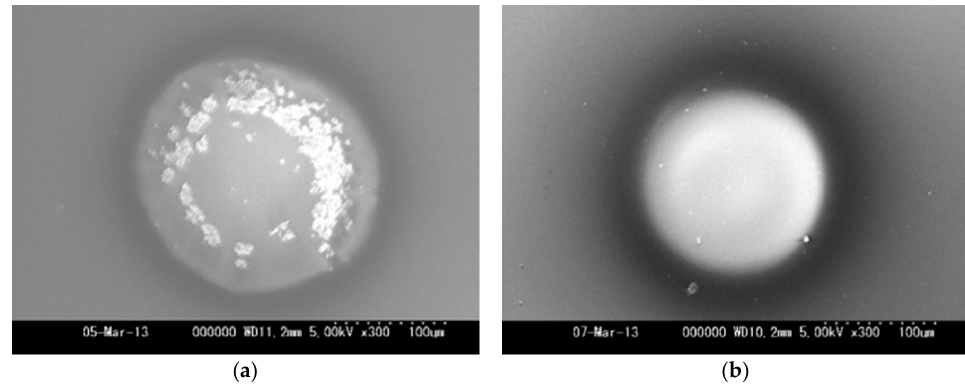
Figure 7. SEM images of cathode (Si) surfaces after 5 s operation at 1000 V source voltage, 6.6 sccm C 2 H 2 flow rate, 80 kPa inlet pressure, and the electrode gap distance of ( a ) 100 and ( b ) 200 μ m. Figure 8a,b show SEM images of a deposited film on Si wafer from top view and side view, respectively, after 15 s operation at 200 μ m gap length, 6.6 sccm C 2 H 2 flow rate with 80 kPa inlet pressure, 1000 V source voltage and 19 μ A initial discharge current. Figure 9 shows an optical microscope image for the deposited film. The deposited film was not uniform but circularly-shaped with a diameter of 220 μ m. As shown in Figure 8b, the deposited film was fairly thick as directly recognized from the tilted angle observation. From the multiple concentric rings for optical interference in the film appeared in Figure 9, the profile was a symmetric shallow mountain shape.